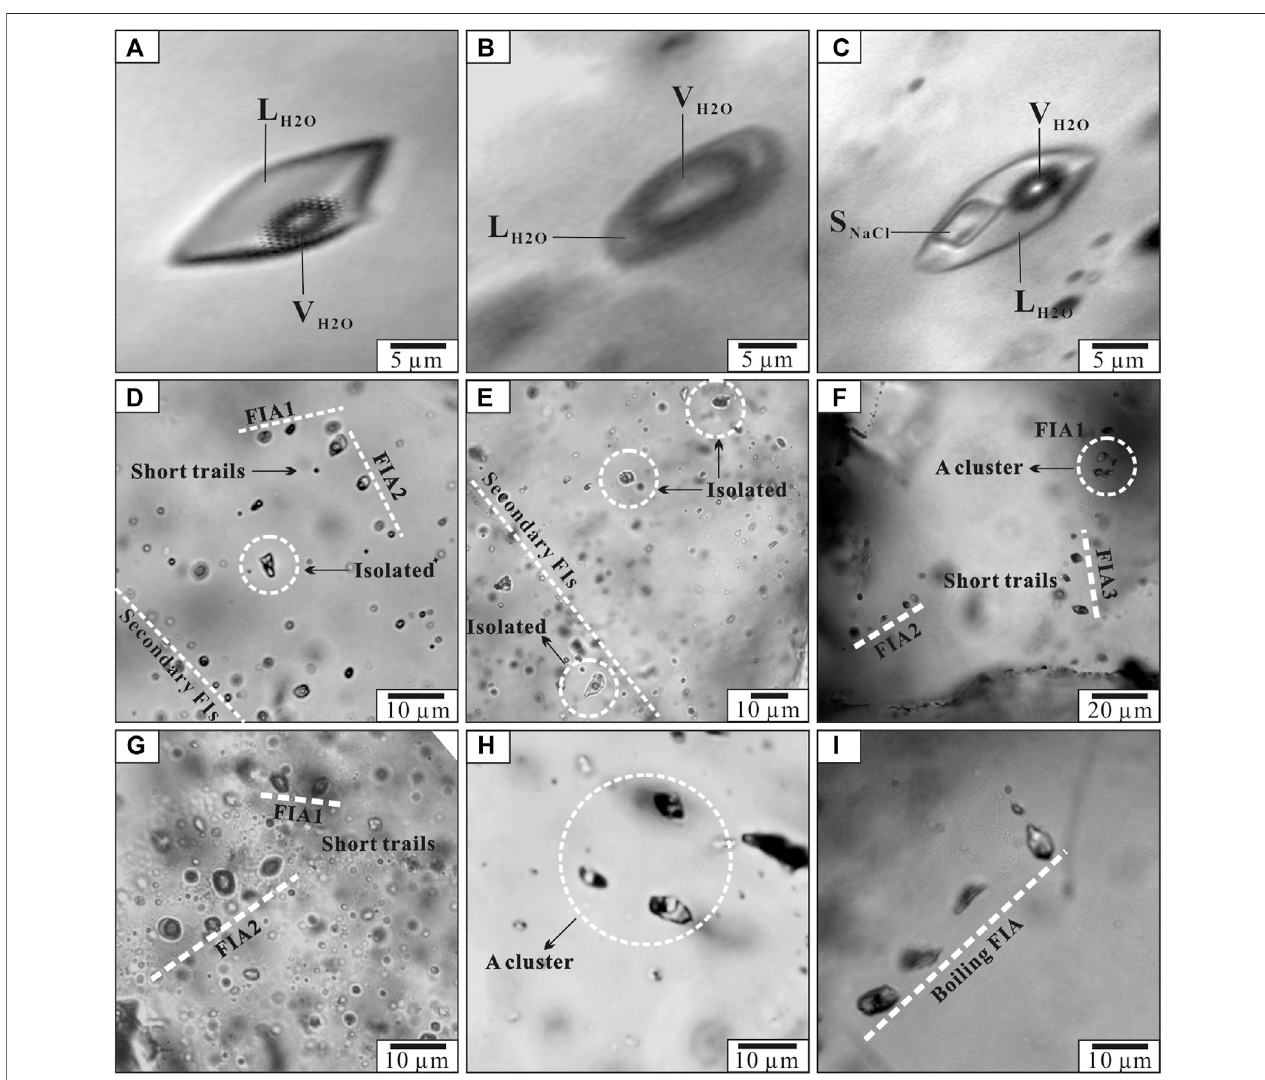
FIGURE5| PhotomicrographsofFIsinquartzfromdifferentstagesoftheHaerdabanPb-Zndeposit (A) TypicalLV-typeFI (B) TypicalVL-typeFI (C) TypicalS-type FI (D) Short trails of pseudo-secondary LV-type FIs in stage-1 quartz (E) Isolated LV-type FIs in stage-2 quartz (F) Short trails of pseudo-secondary LV-type FIs and a cluster of LV-type FIs in stage-3 quartz (G) Short trails of VL-type FIs in stage-3 quartz (H) A cluster of S-type FIs in stage-3 quartz (I) Boiling FIA in stage-3 quartz. Abbreviations: L (liquid phase), V (vapor phase), S (daughter mineral).